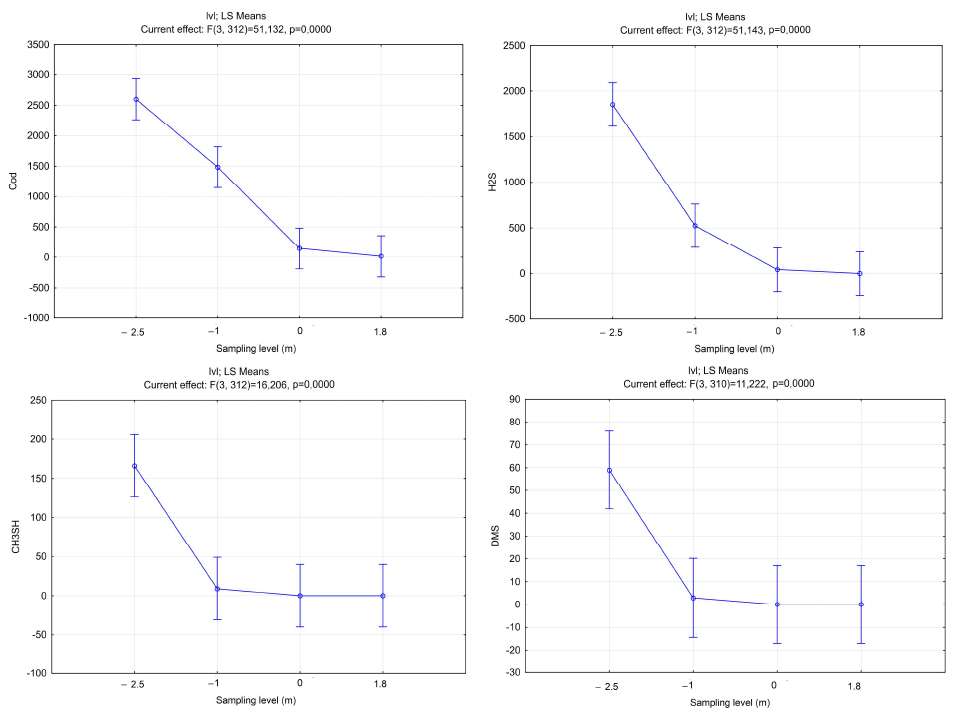
Figure 2. Graphical interpretation of the results of the variable variance analysis: cod (ou/m 3 ), concentrations of selected odorants (mg/m 3 ) against the grouping factor, i.e., sampling level. Effective hypothesis decomposition; vertical bars denote 0.95 confidence intervals.